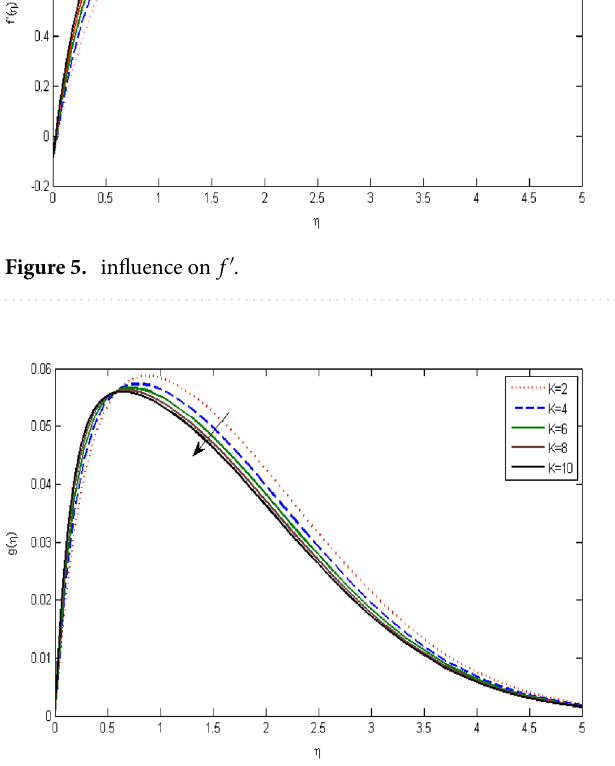
Figure 6. K influence on g .